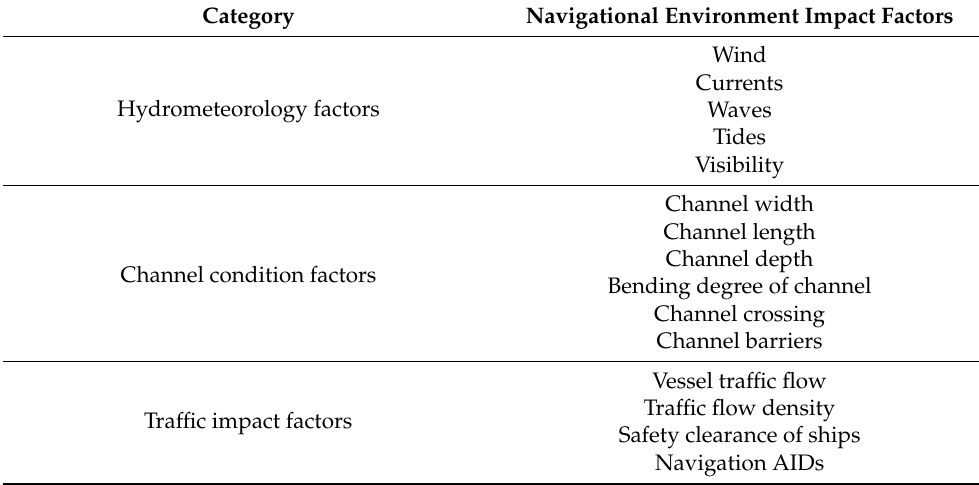
Table 1. Evaluation index system of navigational environment impact